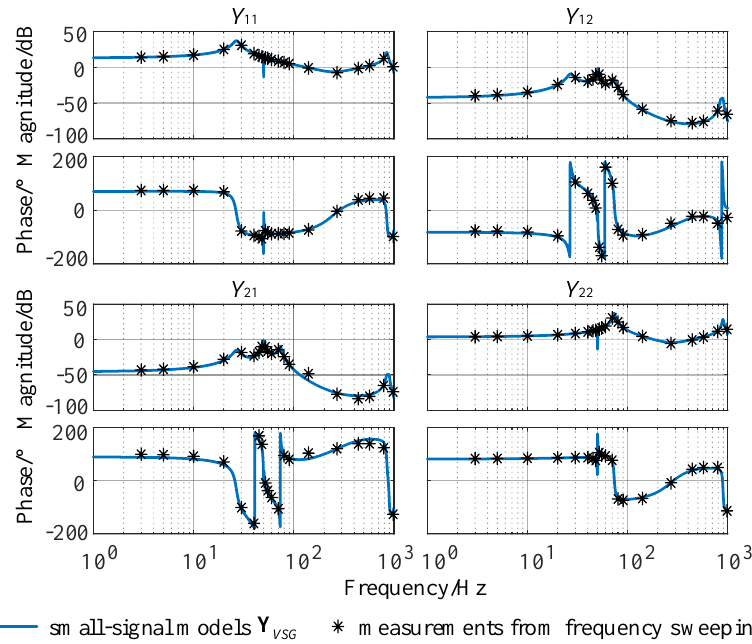
Figure 4. Validation of small-signal models Y VSG .